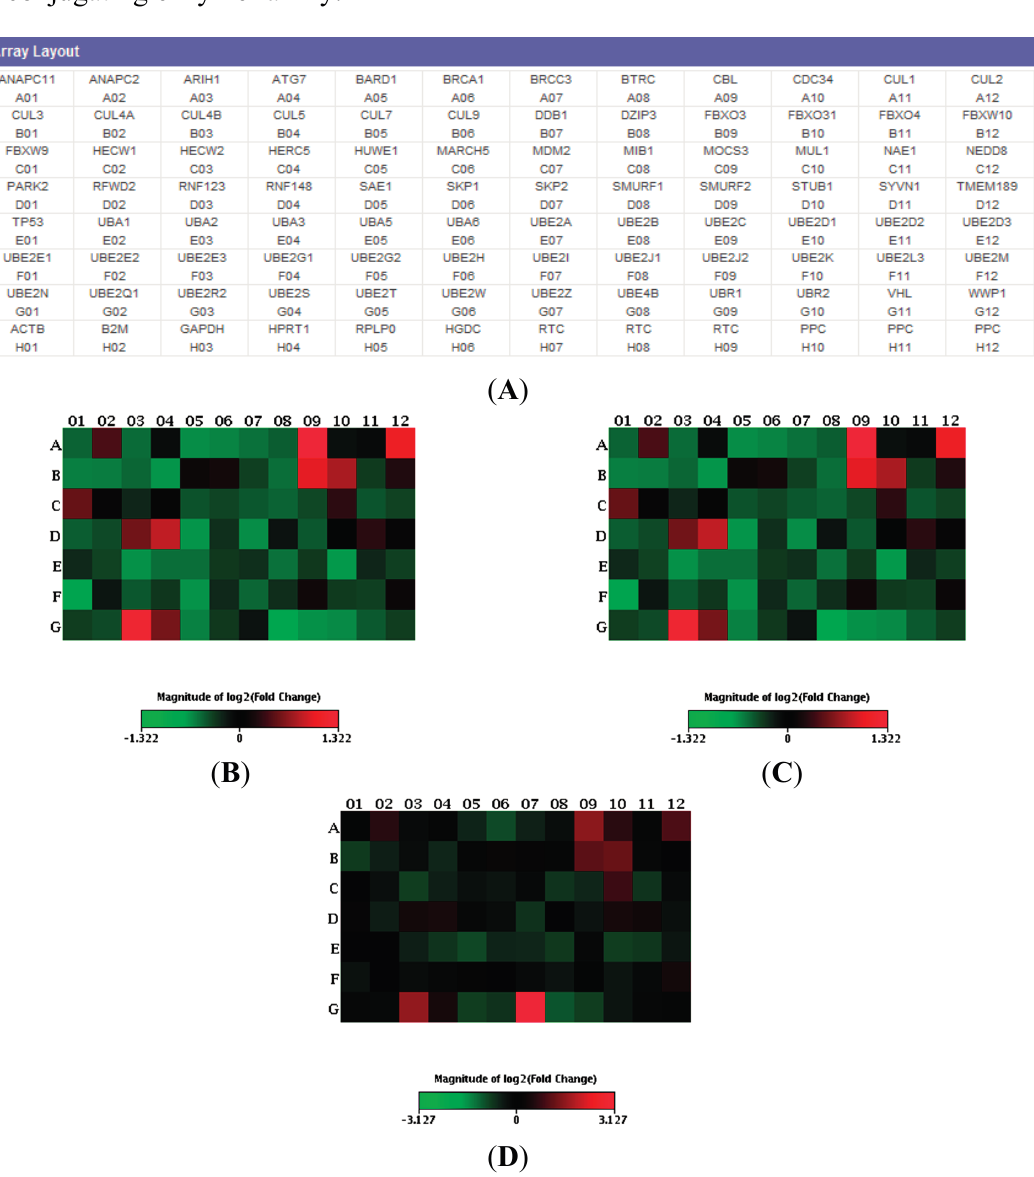
Figure 1. ( A ) Layout of the ubiquitination (ubiquitylation) pathway PCR array (PAHS-079Z). Heat maps of patients versus controls; ( B ) C9ORF72 ; ( C ) sporadic; and ( D ) GRN . Data are expressed as fold change (fold difference) and each square represents a gene of the ubiquitination pathway. Green indicates down-regulation, red